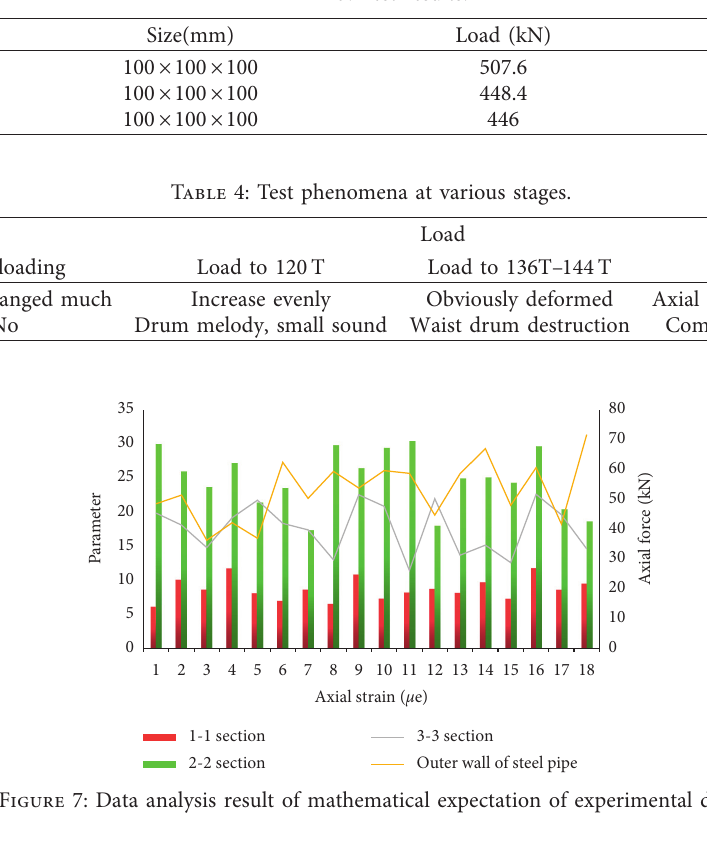
Table 3: Test results.